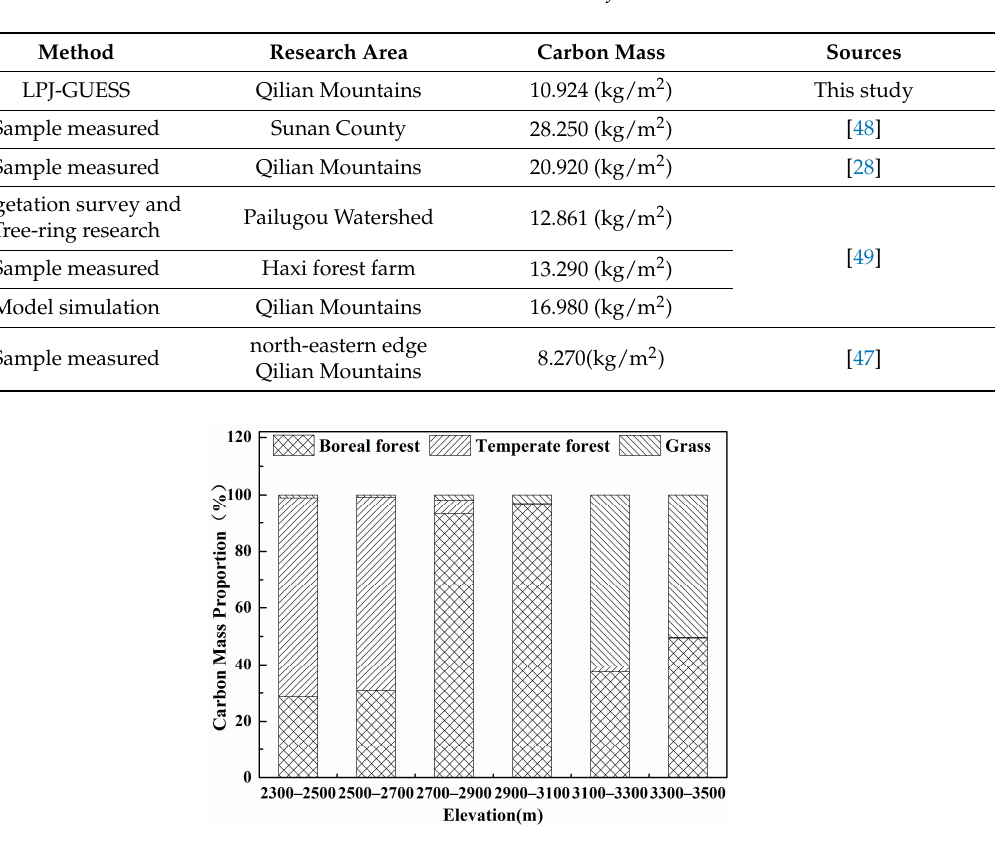
Table 2. Carbon mass calculations for Picea crassifolia in the literature.